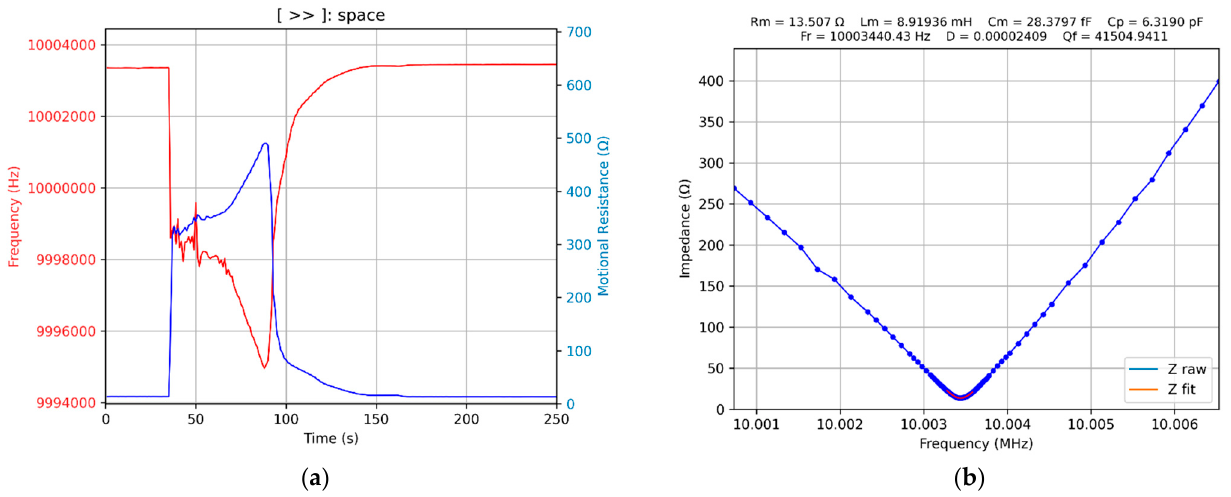
Figure 12. Isopropyl alcohol: ( a ) drop contact with the surface of the QCM sensor, followed by spread and evaporation, ( b ) bioinspired tracking of the series resonance frequency.